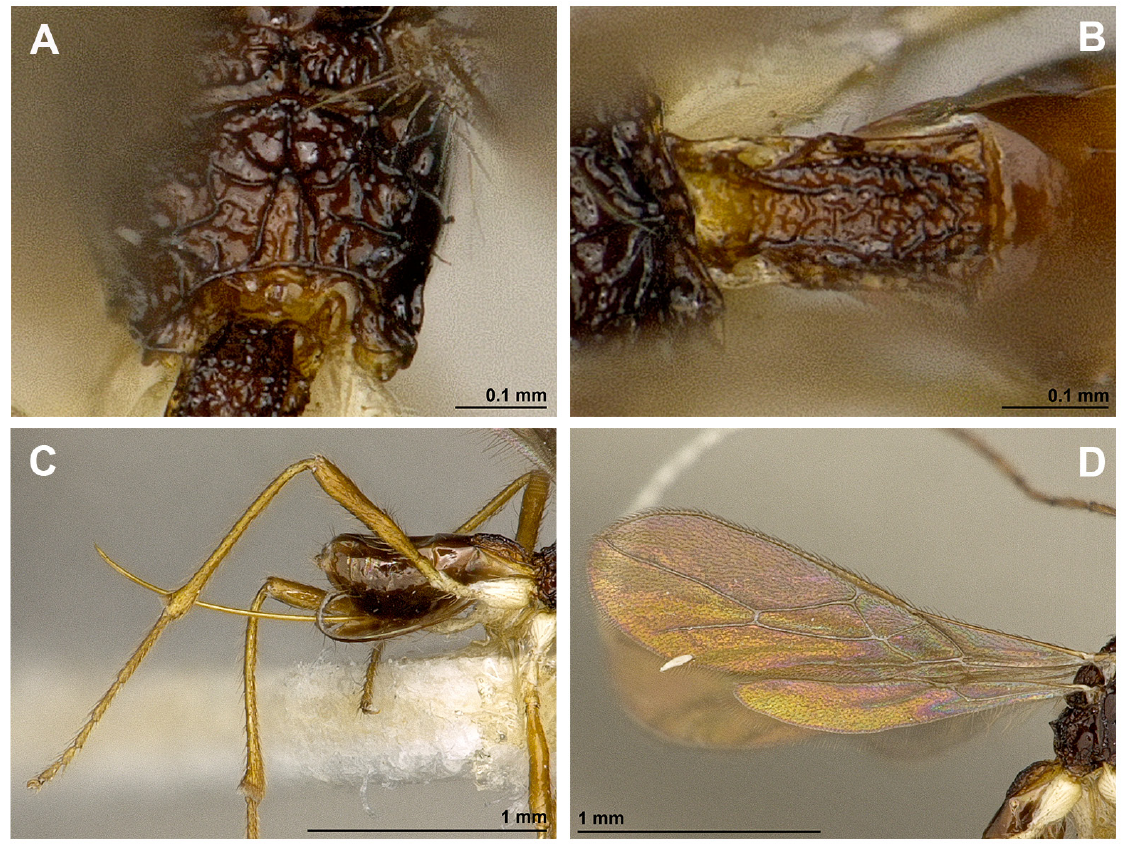
Fig. 12. Asobara cracentis van Achterberg, sp. nov., ♀, holotype (RMNH). A . Propodeum, dorsal view. B . First metasomal tergite, dorsal view. C . Hind leg, metasoma and ovipositor, lateral view. D . Fore and hind